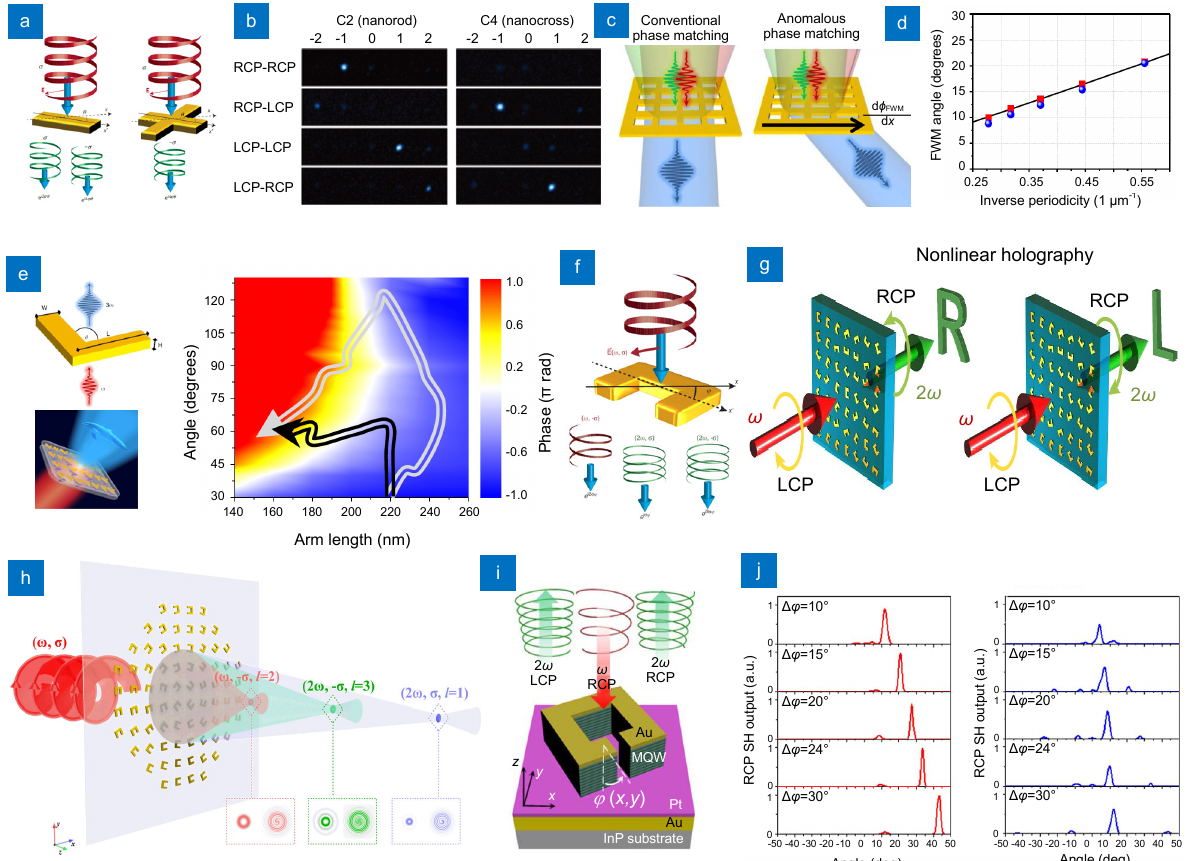
Fig. 5 | ( a ) Schematic of the THG signals and their phases for C2 and C4 nanostructures. ( b ) Measured THG signals from the C2/PFO and C4/PFO metasurfaces with a phase gradient of the nonlinearity. ( c ) Schematic of the anomalous phase matching condition for phase gradient metasurfaces. ( d ) Measured (blue circles), calculated (black line) and simulated (red squares) FWM emission angle as a function of the grating periodicity. ( e ) Left panels: schematic of the V-shaped gold antennas (upper) and the nonlinear hologram metasurfaces that work at THG wavelength (lower). Right panel: the phase of the THG signals for V-shaped antennas with different arm lengths and intersection angles. ( f ) Schematic of the linear and nonlinear PB phases for a split ring resonator. ( g ) Schematic of the nonlinear metasurface that can generate different SHG holographic images for different CP states. ( h ) Schematic of the nonlinear metasurface that can simultaneously generate three focused optical vortices with different topological charges and different focal lengths. ( i ) Schematic of the unit cell of the nonlinear phase gradient metasurface based on quantum well structure. ( j ) Far field profiles of RCP and LCP second harmonic wave output from the metasurfaces with different phase gradients. Figure repro- duced from: (a–b) ref. 172 , Nature Publishing Group; (c–d) ref. 175 , Nature Publishing Group; (e) ref. 183 , Nature Publishing Group; (f–g) ref. 184 , Nature Publishing Group; (h) ref. 186 , Wiley-VCH; (i–j) ref. 188 , Optical Society of